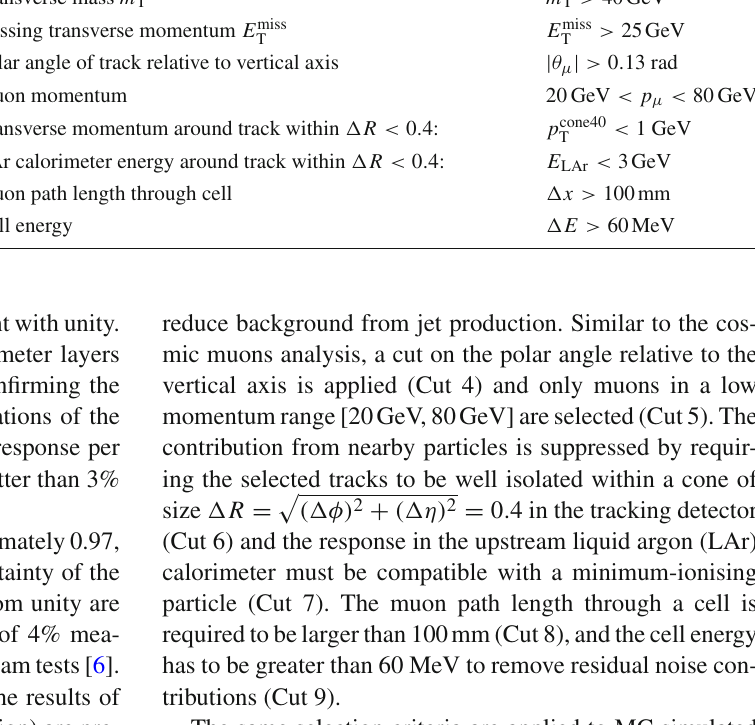
Table 6 Selection criteria applied to the events, tracks, and muons for the collision muon